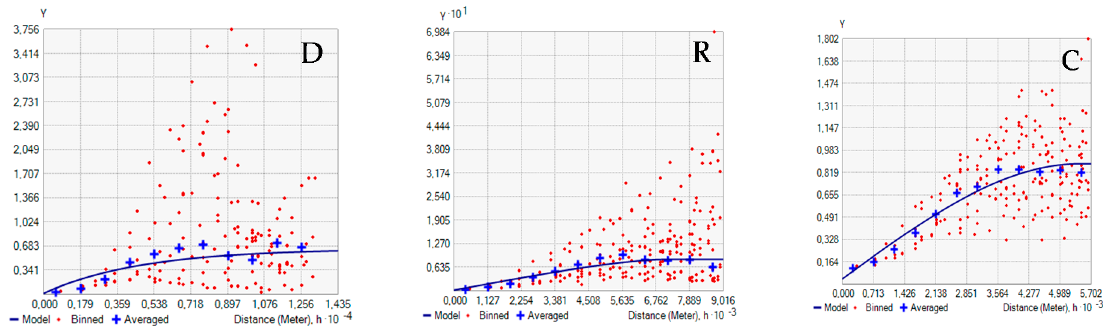
Figure 6. Adjusted theoretical variogram analysis for the Depth to water ( D ), net Recharge ( R ) and hydraulic Conductivity ( C ). Table 5. Summary of the best-fit models for parameters Depth to water, net Recharge and hydraulic Table 4. Summary statistics of parameters data (D, R and C). Conductivity.